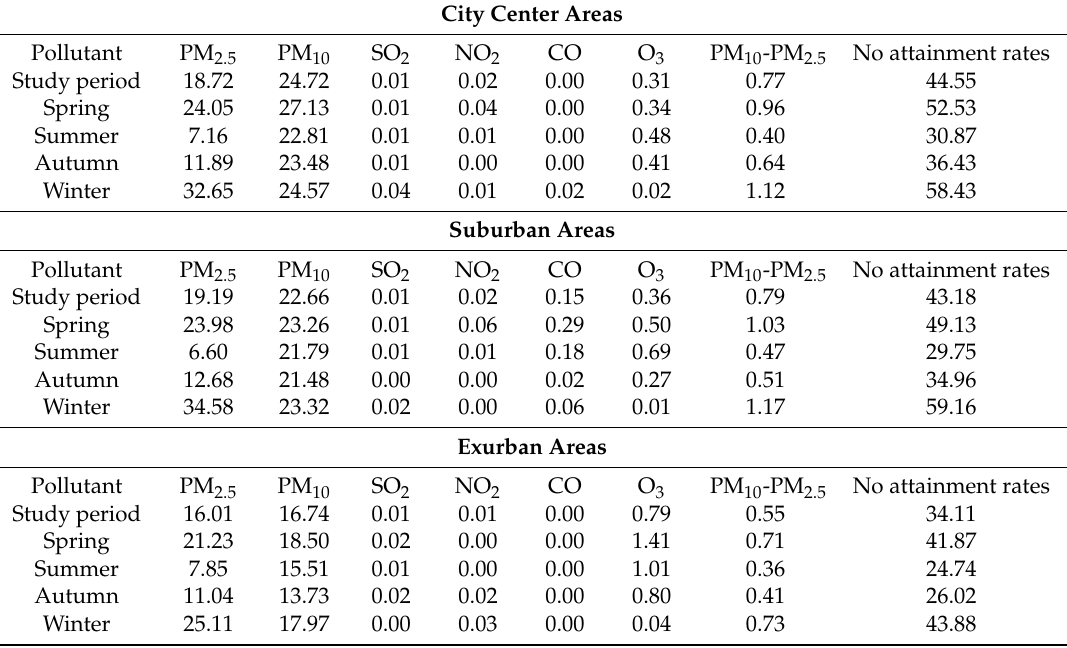
Table 3. The contributions of different air pollutants to the major pollutant (%) during the study period and the four